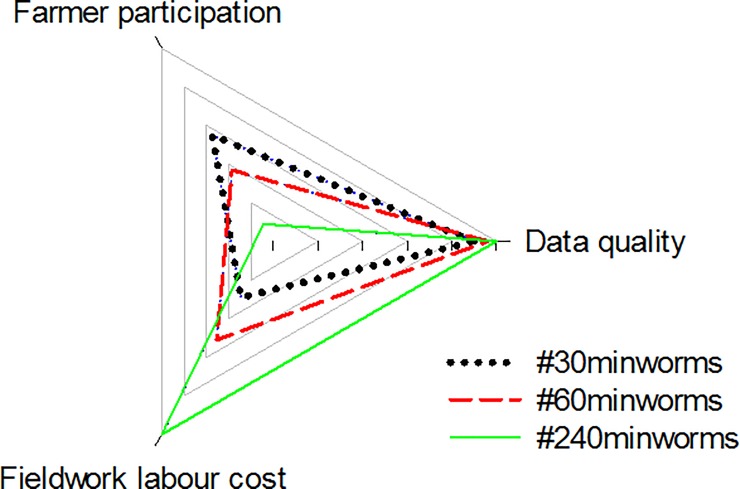
Trade-offs between earthworm fieldwork effort (30–240 mins) and data quality, farmer participation levels and labour costs.